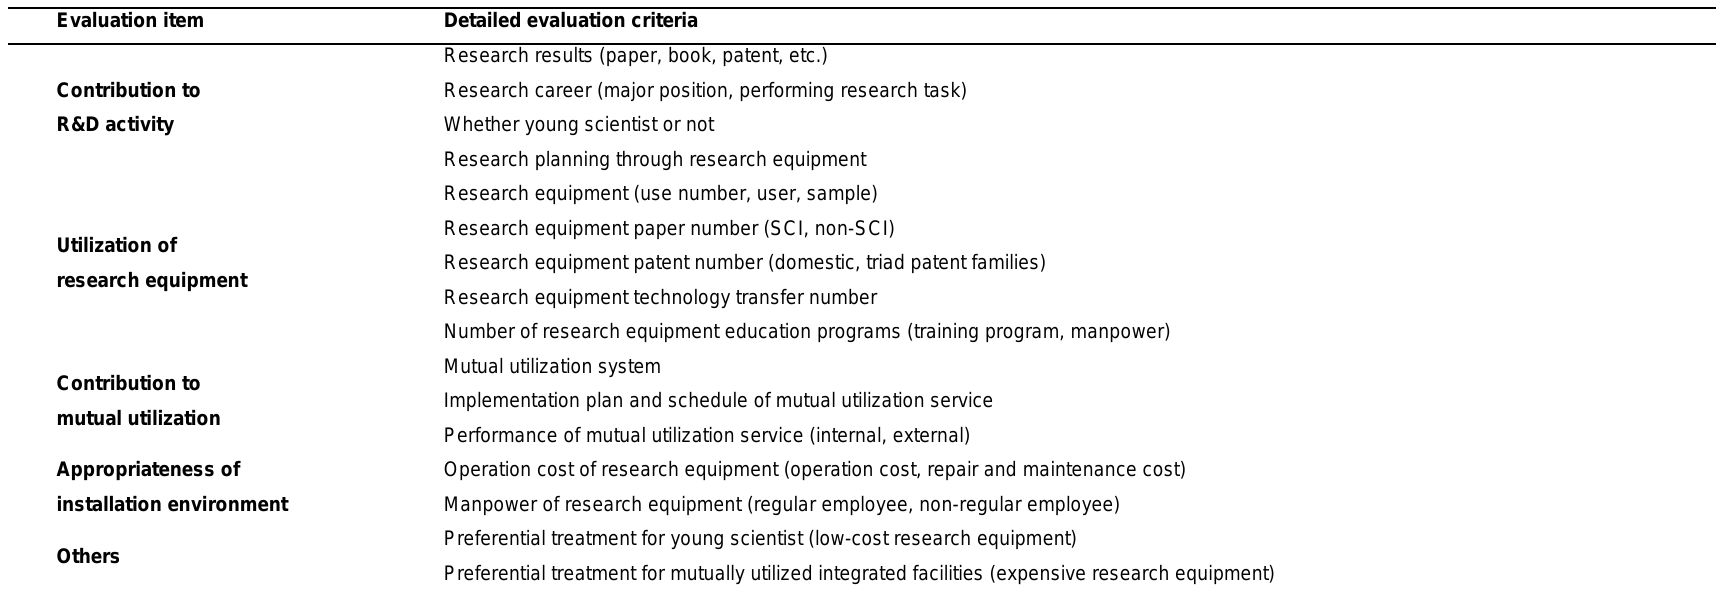
Table 17. Evaluation criteria design for relocation of research